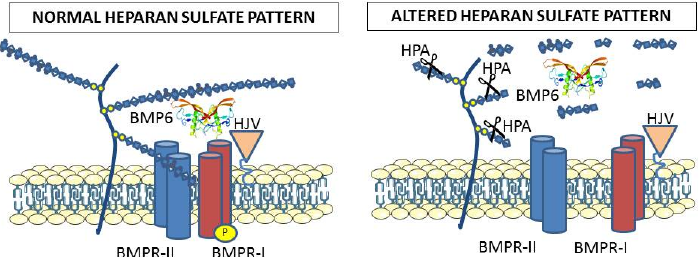
Figure 2. The heparan sulfates bound to proteoglycans cover cellular membranes and are thought to participate in the binding of BMP6 to the receptors for activation of the SMAD signaling. This is supported by the evidence that alteration of the endogenous heparan sulfate structure by heparanase overexpression strongly reduced BMP6 signaling and hepcidin expression in cells and mice. Exogenous heparins probably interfere with the roles of endogenous heparan